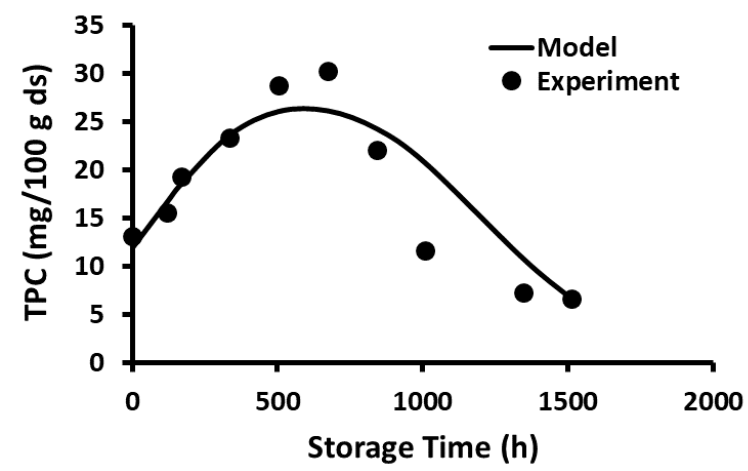
Figure 3. Polyphenol content during storage at 40 °C for 63 days.